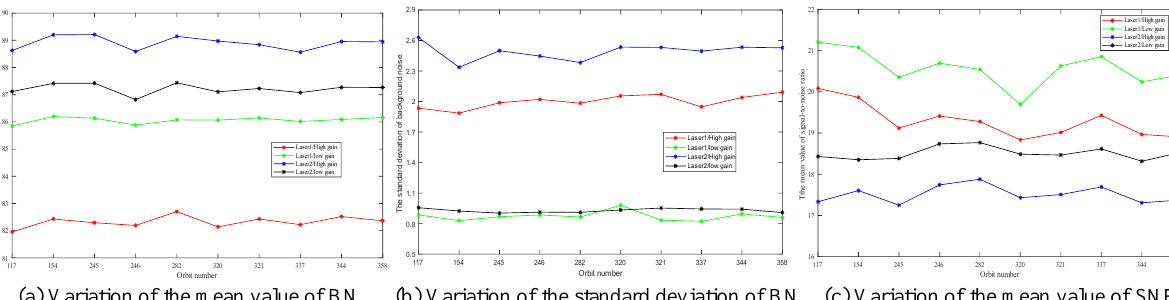
Table 3. The calculation results of the transmitted waveform during different time and orbits